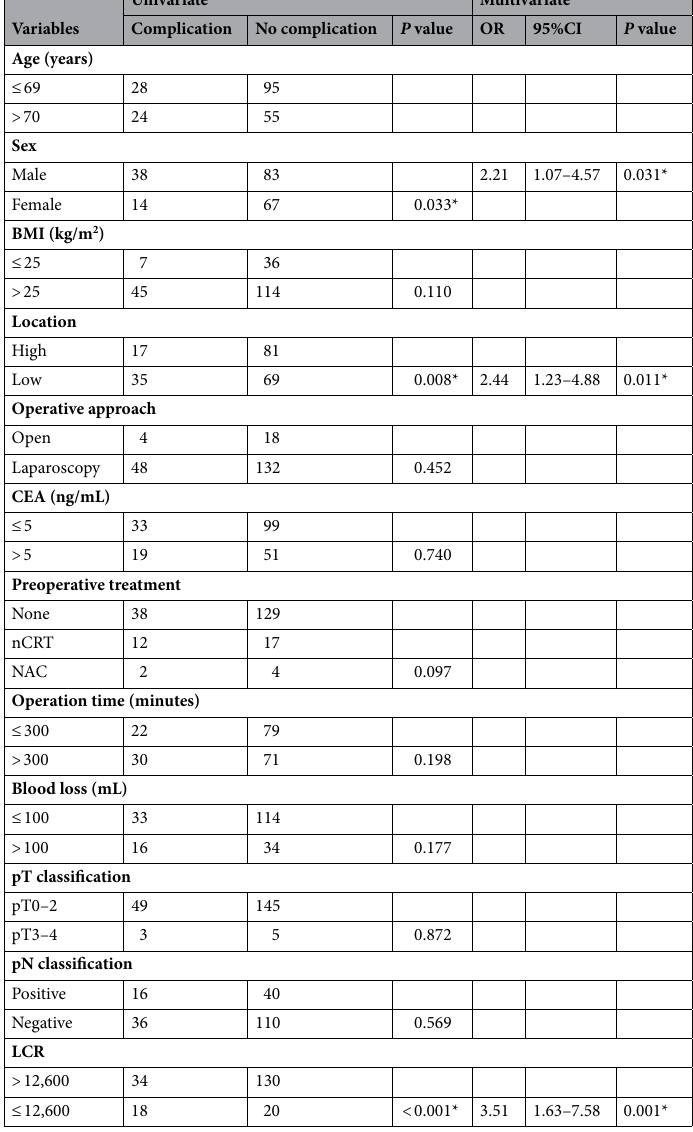
Table 4. Univariate and multivariate analyses showing the association of clinicopathological characteristics and LCR with the occurrence of postoperative complications. CI confidence interval, BMI body mass index, CEA carcinoembryonic antigen, nCRT neoadjuvant chemoradiotherapy, NAC neoadjuvant chemotherapy, pT pathological stage based on the tumor size and spread of cancer to nearby tissue, pN pathological stage based on spread of cancer to nearby lymph nodes, LCR lymphocyte count/C-reactive protein ratio. * P <